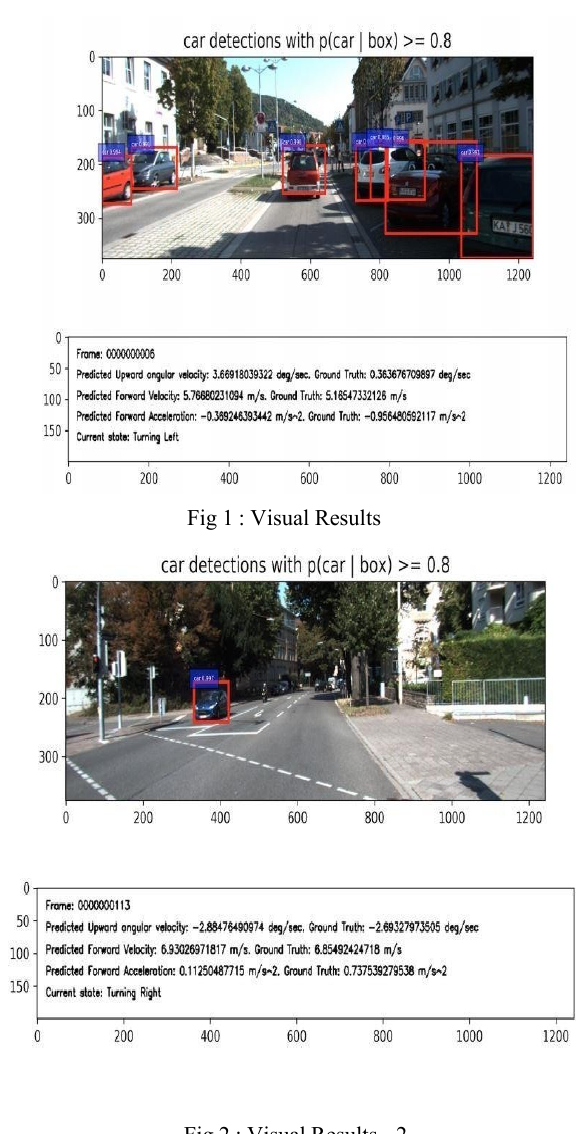
Fig 2 : Visual Results - 2